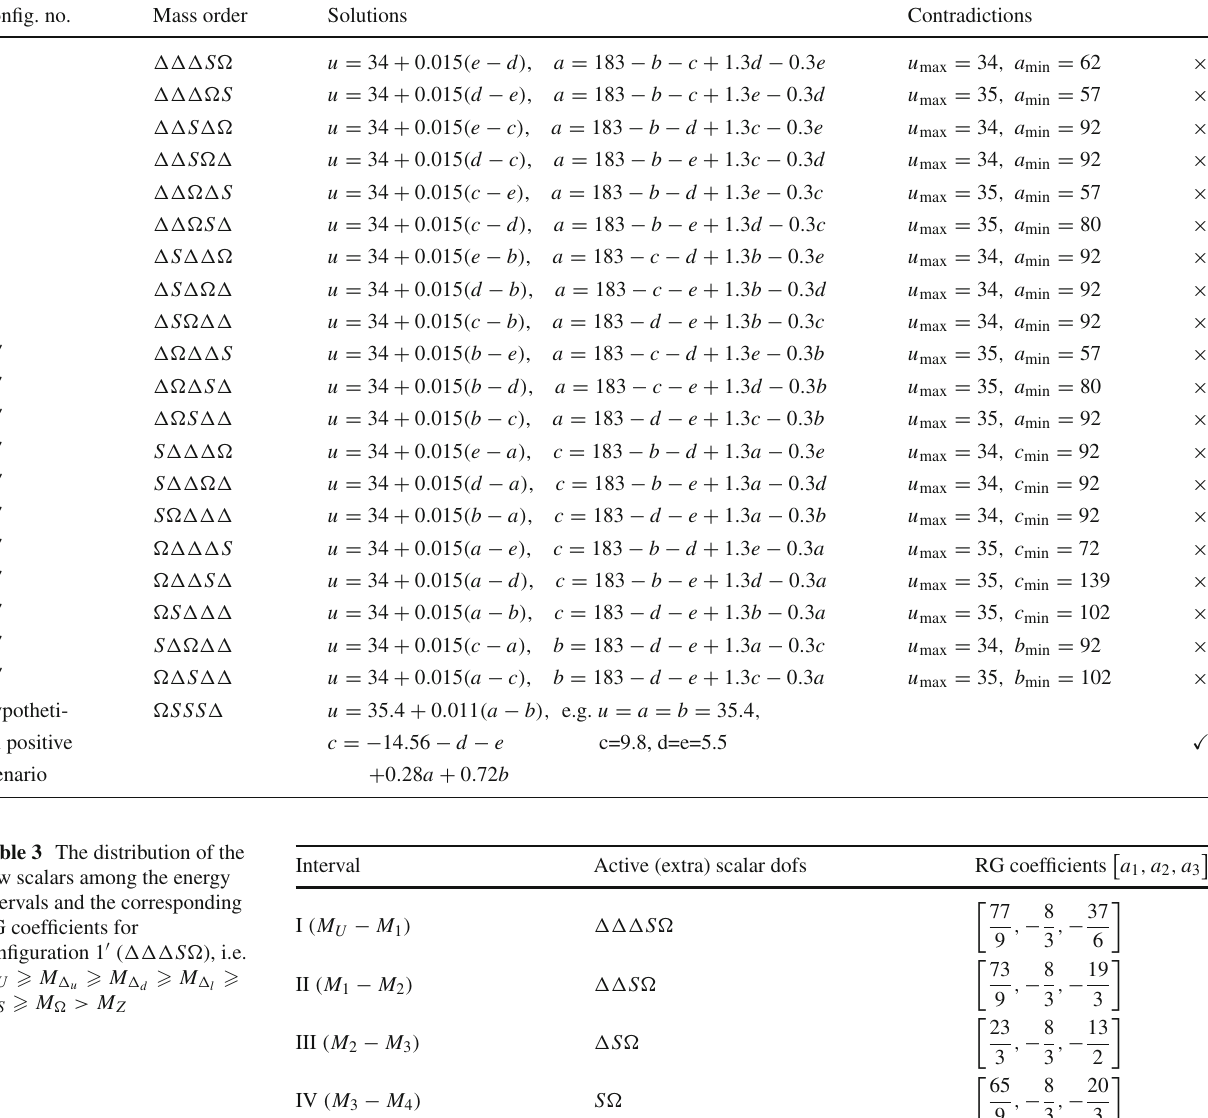
Table 2 The main result of this paper. The configurations of mass hier- archy and the corresponding equations in the general case, in which the extra scalars acquire random order of masses between the elec- troweak scale and the presumed unification scale, are given. The super- script ( (cid:16) ) indicates that the configurations belong to the general case. The mass orderings in the second column are given in the decreasing order from left to right. Similarly, ( u , a , b , c , d , e ) denote mass scales as u = ln M U / GeV, a = ln M 1 / GeV ... , where M U is the unification scale in each case, and M i is the mass of the scalar i , for i = 1 ,..., 5. Config. no.